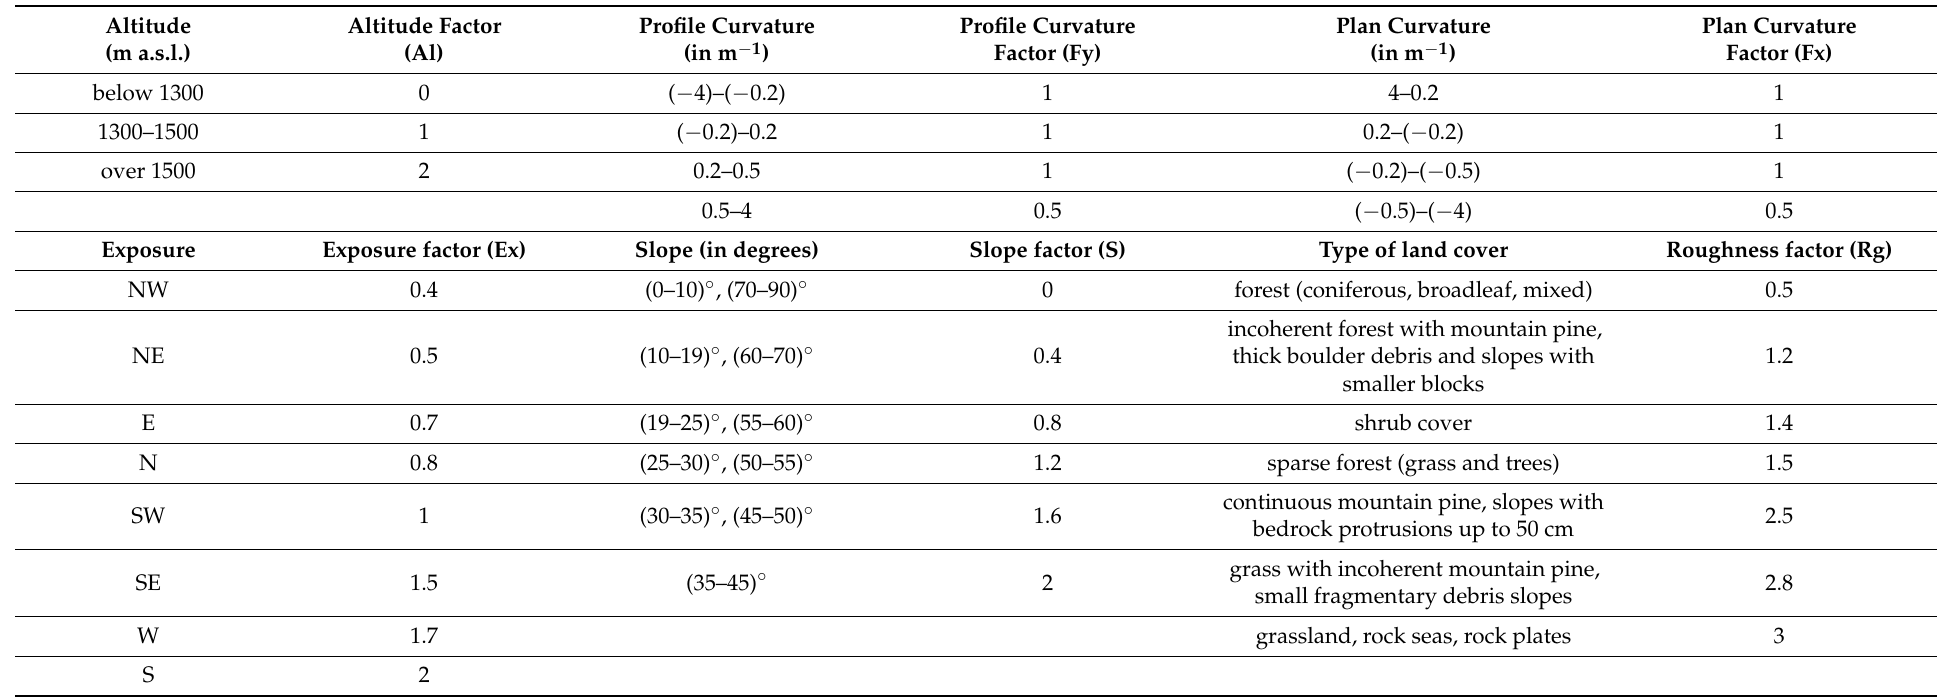
Table 1. Values of variables entering the calculation of trigger zones